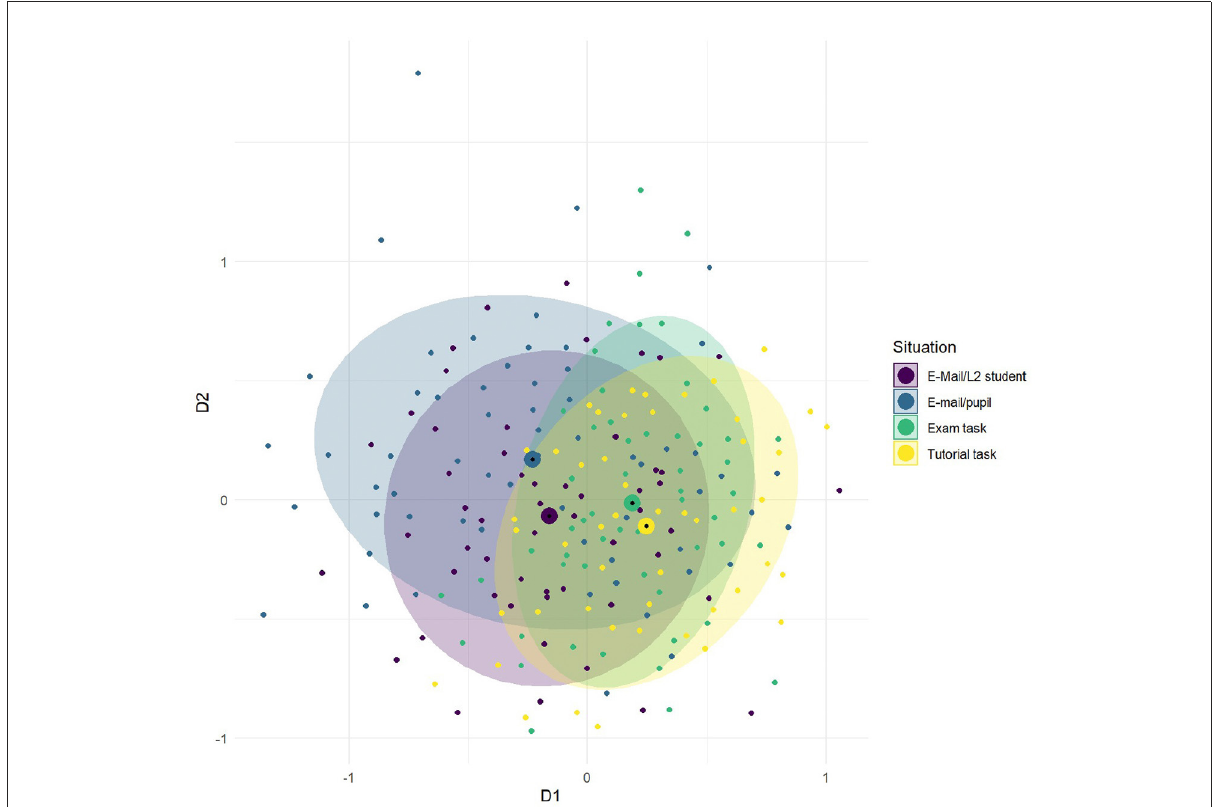
FIGURE6 Project C05: Multidimensional scaling plot of a two-dimensional solution. D1—institutional setting (school, university); D2—social relation to the addressee. The observations (explanations) are colored according to the eliciting contexts. Ellipses were added to support visualization of the proximity relations.